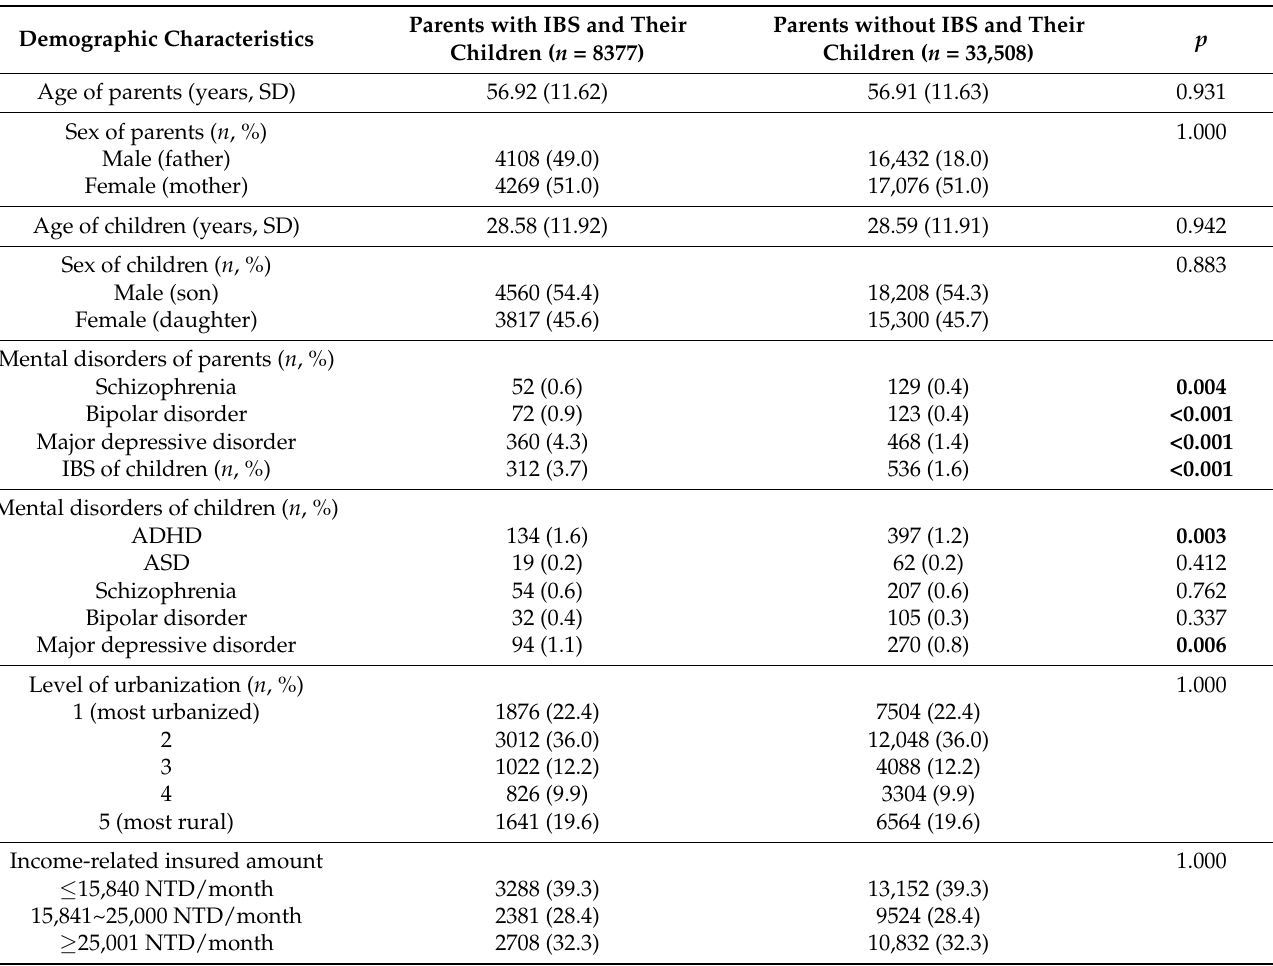
Table 1. Demographic data and prevalence of mental disorders among the offspring of parents with or without IBS. Demographic